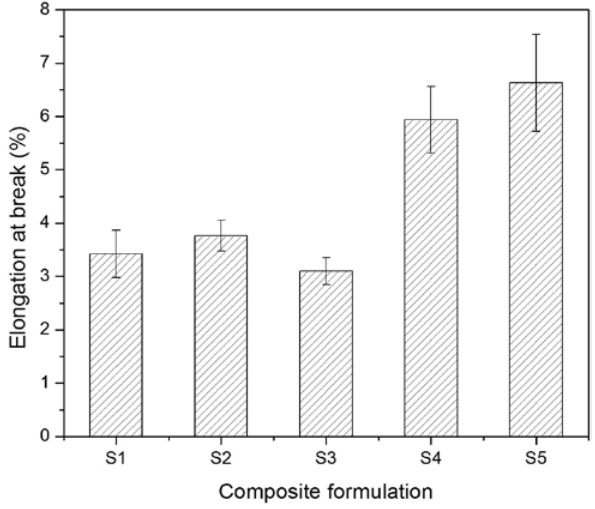
Figure 6: Percent elongation at break of the